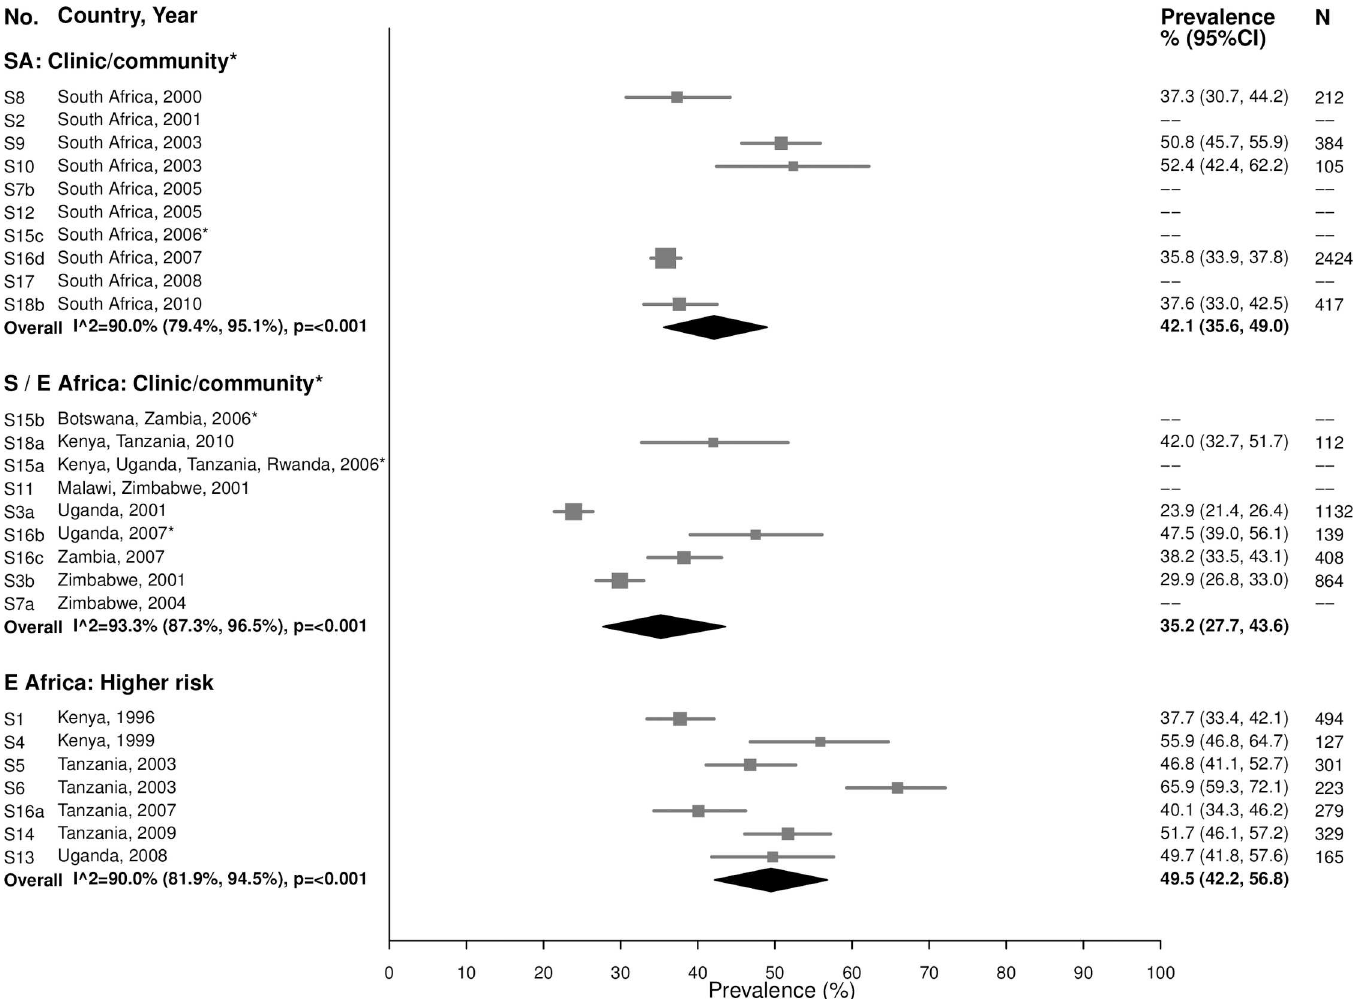
Fig 13. Bacterial vaginosis prevalence among 15–24-year-olds. The area of the marker is proportional to the square root of the sample size. Studies with no estimate presented did not meet the inclusion criteria for this infection and age group. Year presented is the median year that baseline data were collected during the study. (cid:3) Includes studies of HIV-discordant couples. E Africa, Eastern Africa; SA, South Africa; S/E Africa, Southern and Eastern Africa.